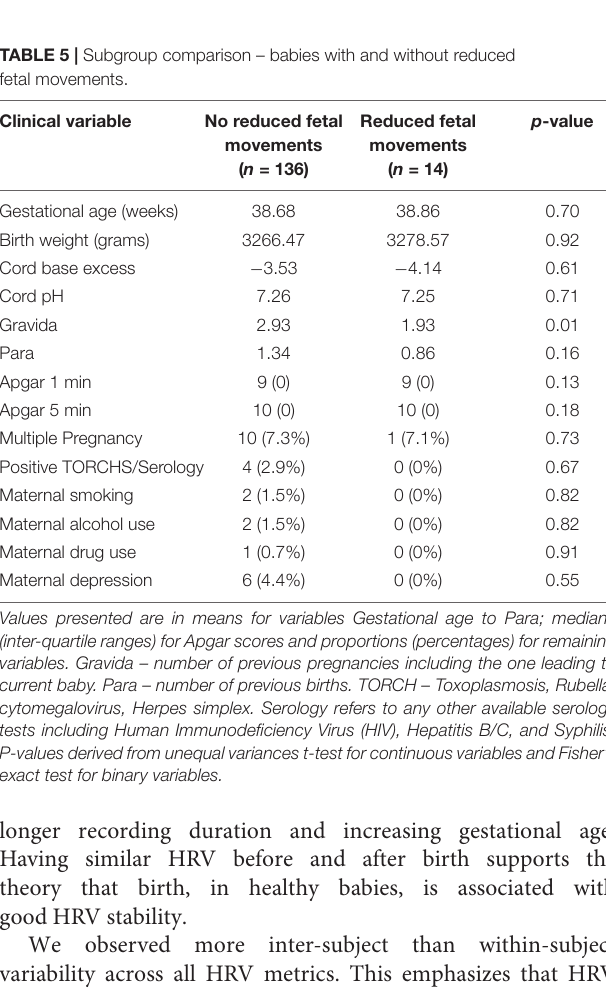
FIGURE 5 | HRV changes in babies whose mothers reported reduced fetal movements. For abbreviations of HRV metrics, please refer to Table 1 . Upper panels present HRV data scatter over time and linear trend lines for heart rate (comparative) and the three HRV metrics that were significantly associated with maternal reports of reduced fetal movements. Red lines represent babies whose mothers reported reduced fetal movements and blue lines represent babies whose mothers did not. The lower panels present the means and 95% confidence intervals for those metrics.